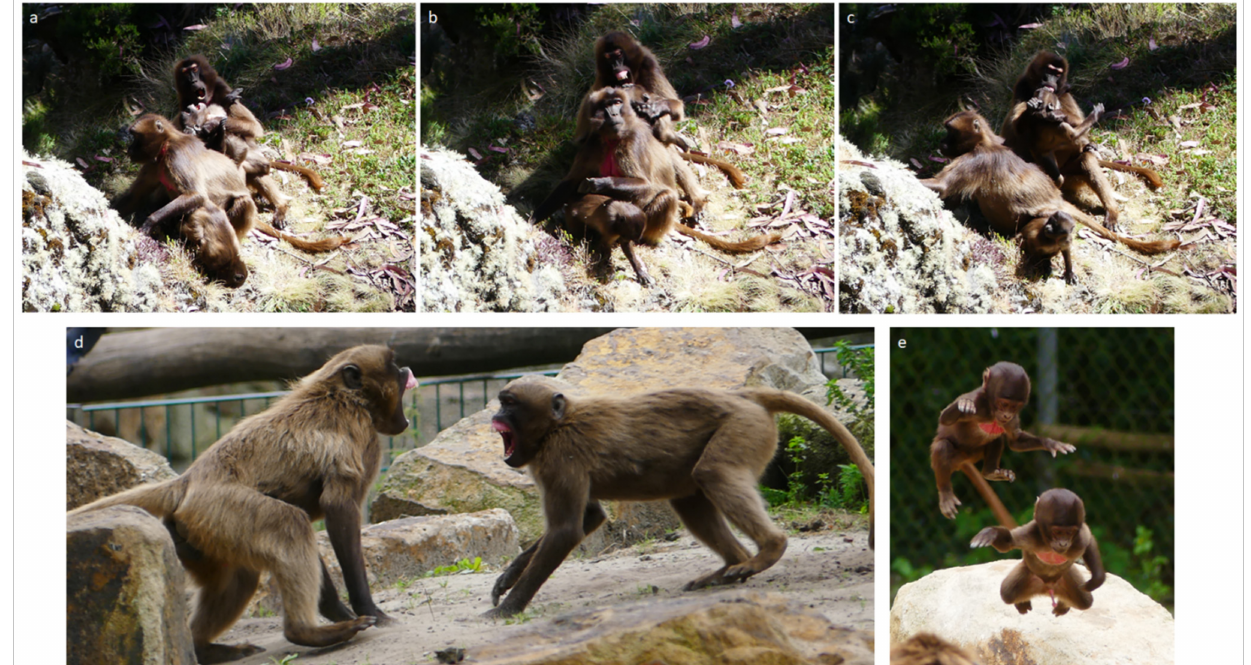
Figure 3. Social play in geladas. ( a – c ) sequences of an alloparental play fighting session involving an adult female and an immature subject (Amhara region, Ethiopia); ( d ) rapid facial mimicry of full play face between two subadult males at the NaturZoo (Rheine, Germany); ( e ) play running between two black infants at the NaturZoo (Rheine, Germany). Photo: Elisabetta